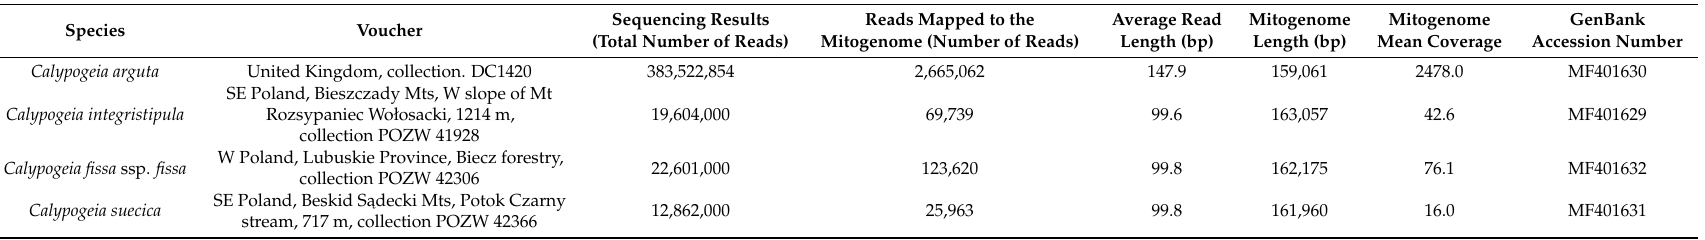
Table 1. Sample species, voucher specimens and sequencing results of species used in this study. Mean coverage calculated as follows: number of reads that mapped to the mitogenome x average read length (bp)/mitogenome length